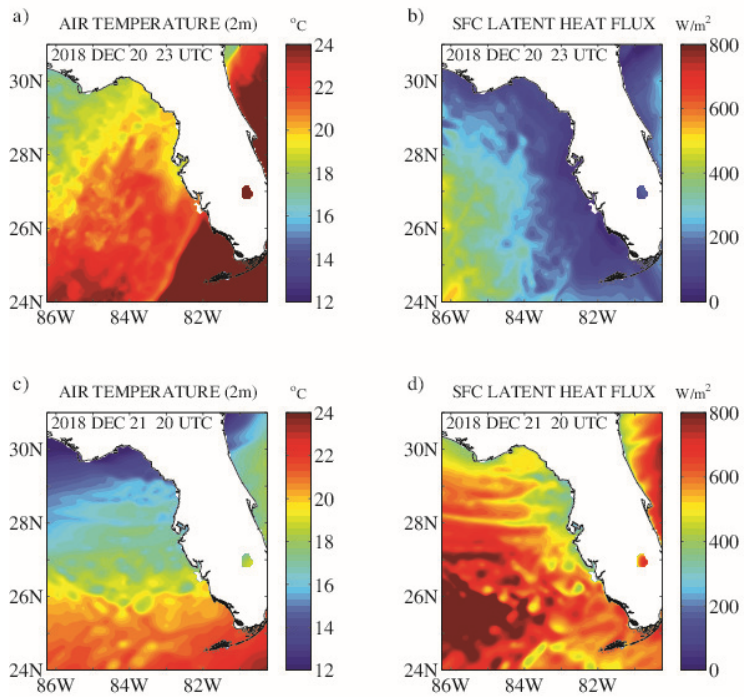
Figure 2. ( A ) COAMPS air temperature (2-m) 20 December 2300 UTC; ( B ) COAMPS Surface Latent Heat Flux 20 December 2300 UTC; ( C ) COAMPS air temperature (2-m) 21 December 2000 UTC; Heat Flux 20 December 2300 UTC; ( c ) COAMPS air temperature (2-m) 21 December 2000 UTC; and and ( D ) COAMPS Surface Latent Heat Flux 21 December 2000 UTC. ( d ) COAMPS Surface Latent Heat Flux 21 December 2000